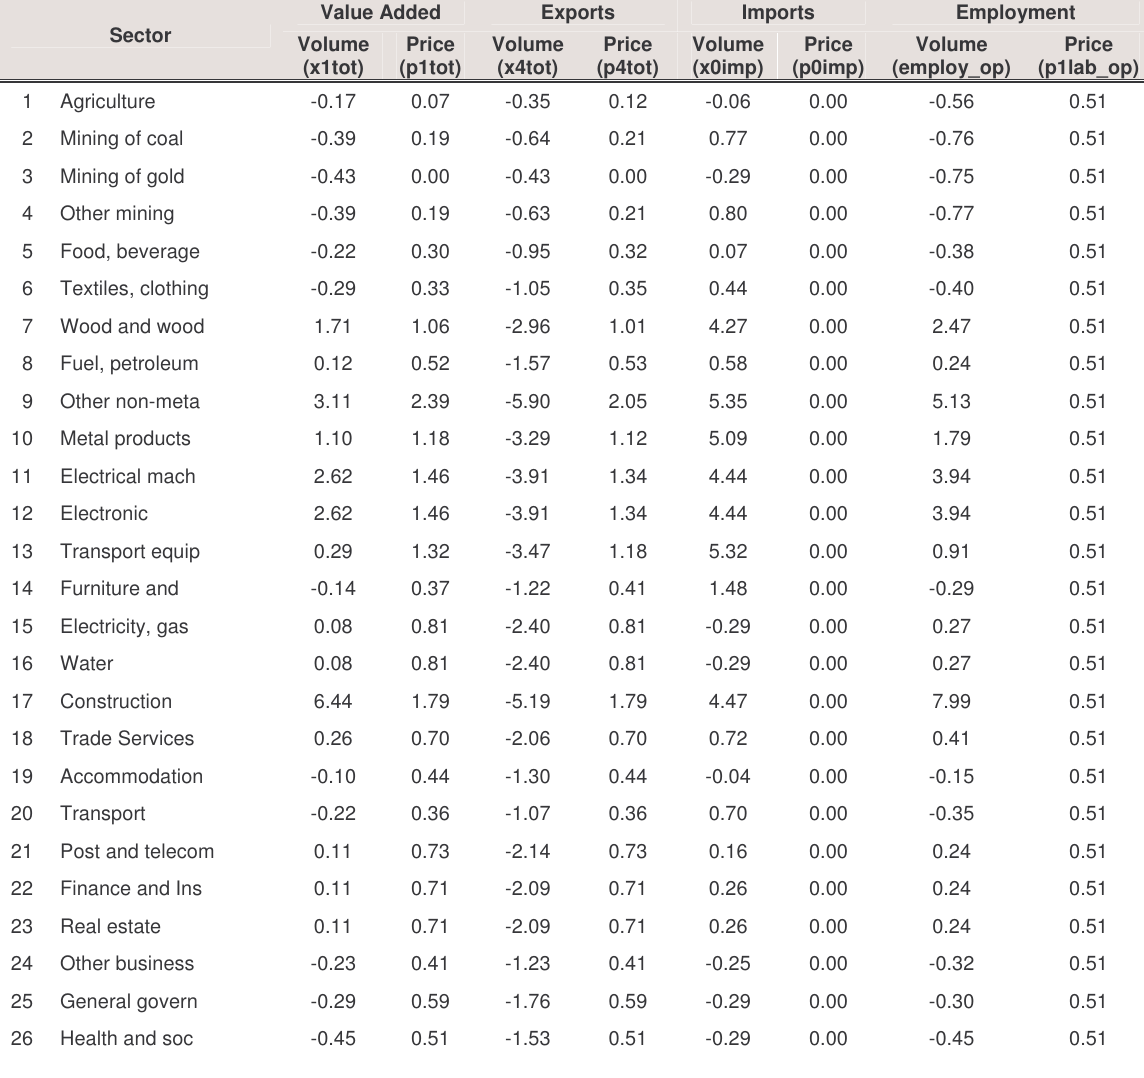
Table 5: Sector results for scenario 1 (structural